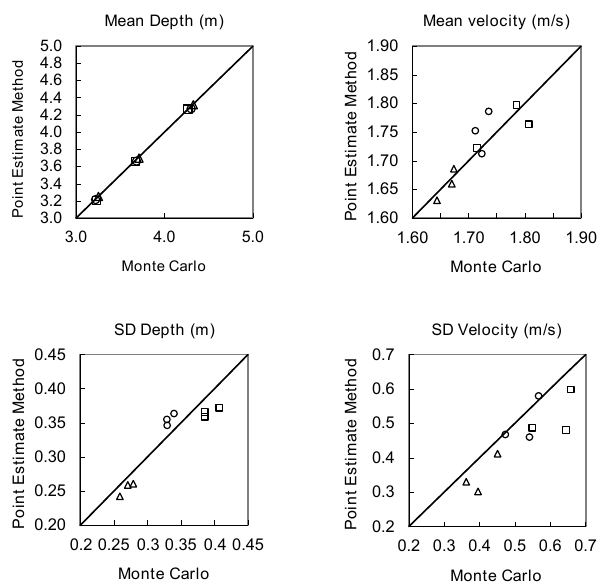
Fig. 6. Uniform flow model. Mean and standard deviations of wa- ter depth and velocity predicted by point-estimate method against Monte Carlo. Results for n i distributions: uniform (squares), nor- mal (circles) and triangular (triangles). Each point on the chart cor- responds to a flow